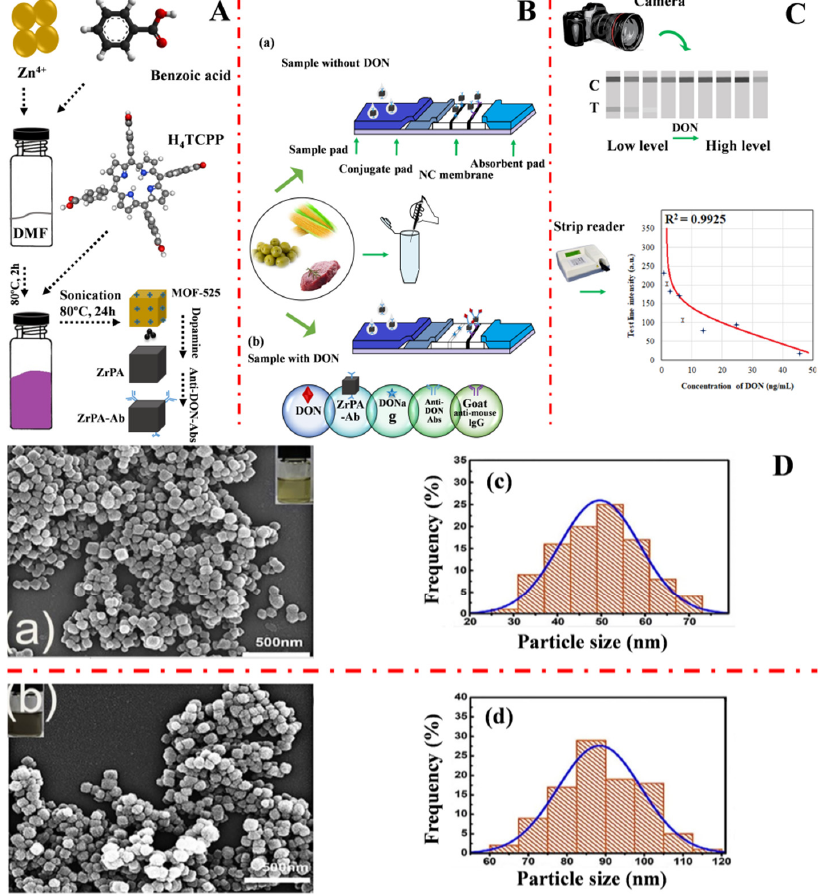
Figure 2. ( A ) Graphical illustration of the MOF-525, ZrPA, and ZrPA-Ab synthesis stages; ( B ) The ZrPA-working ICA concept of sensing deoxynivalenol; ( C ) Interpretation of the findings of the experiment, and ( D ) ( a , b ) MOF-525 and ( c , d ) ZrPA SEM images and particle sizes, respectively. Adapted with permission from the article of [59]. 2022, Elsevier.